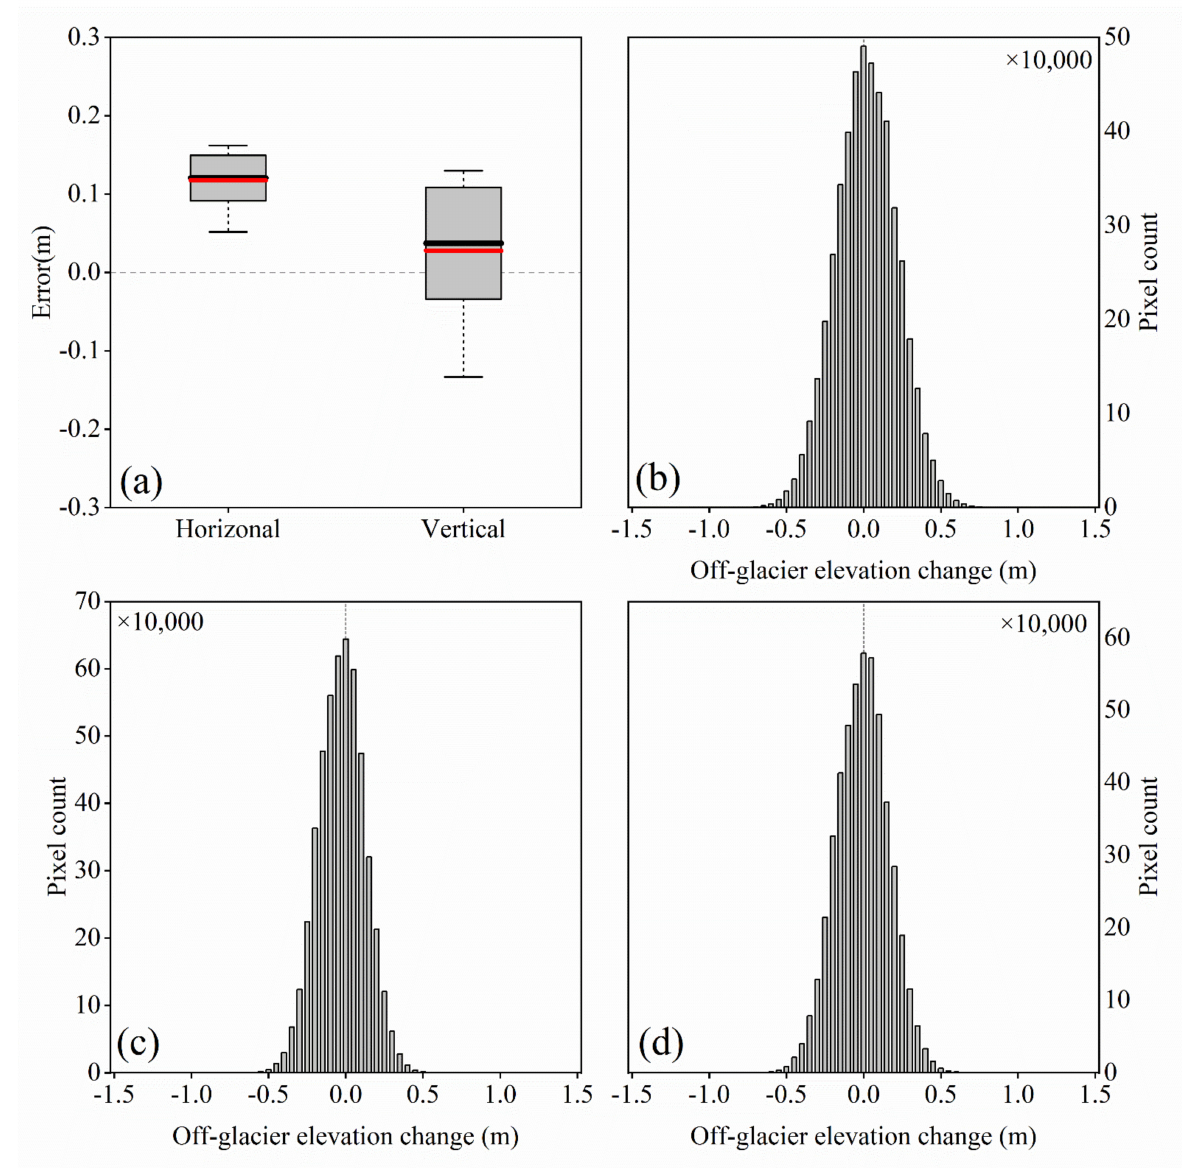
Figure 4. ( a ) The boxplots of the errors that were measured between the checkpoints (Figure 2) and the 202011 orthophotos (horizontal) and DSM (vertical). The boxes represent the interquartile ranges, the whiskers the quartile to extreme ranges, the thick black lines the medians and the thick red lines the means. ( b – d ) The histograms of elevation differences between DSMs